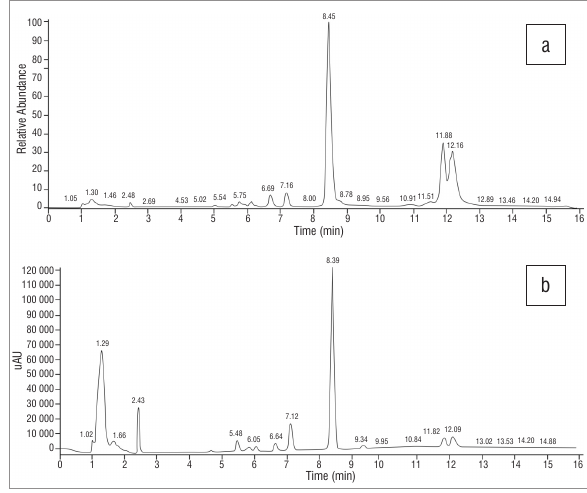
Figure 7 : Chromatograms of Sceletium tortuosum derived from (a) electrospray ionisation mass spectroscopy and (b) high- performance liquid chromatography with UV. The HPLC-UV profile of the S. expansum sample (Figure 8) showed three peaks at RTs of 5.44 min (unidentified), 7.07 min (mesembrenone) and 8.34 min (mesembrine). The alkaloids mesembrenone and mesembrine were assayed by HPLC-UV and found to be present at 0.03% and 0.30%, respectively. Mesembranol and epimesembranol were below their limits of detection using HPLC-UV; however, the presence of these alkaloids was confirmed by MS detection. The LC-MS profile showed peaks at 5.49 min, 6.70 min, 7.13 min, 8.42 min and 12.51 min (Figure 8) which corresponded to m/z values of 274, 292 (mesembranol), 288 (mesembrenone), 290 (mesembrine) and 292 (epimesembranol). The ionised peak at 5.49 min was also found in S. strictum, which had a m/z of 274, corresponding to 4’- O -demethyl-mesmbrenone or O -methyl- joubertiamine (MWs=273).